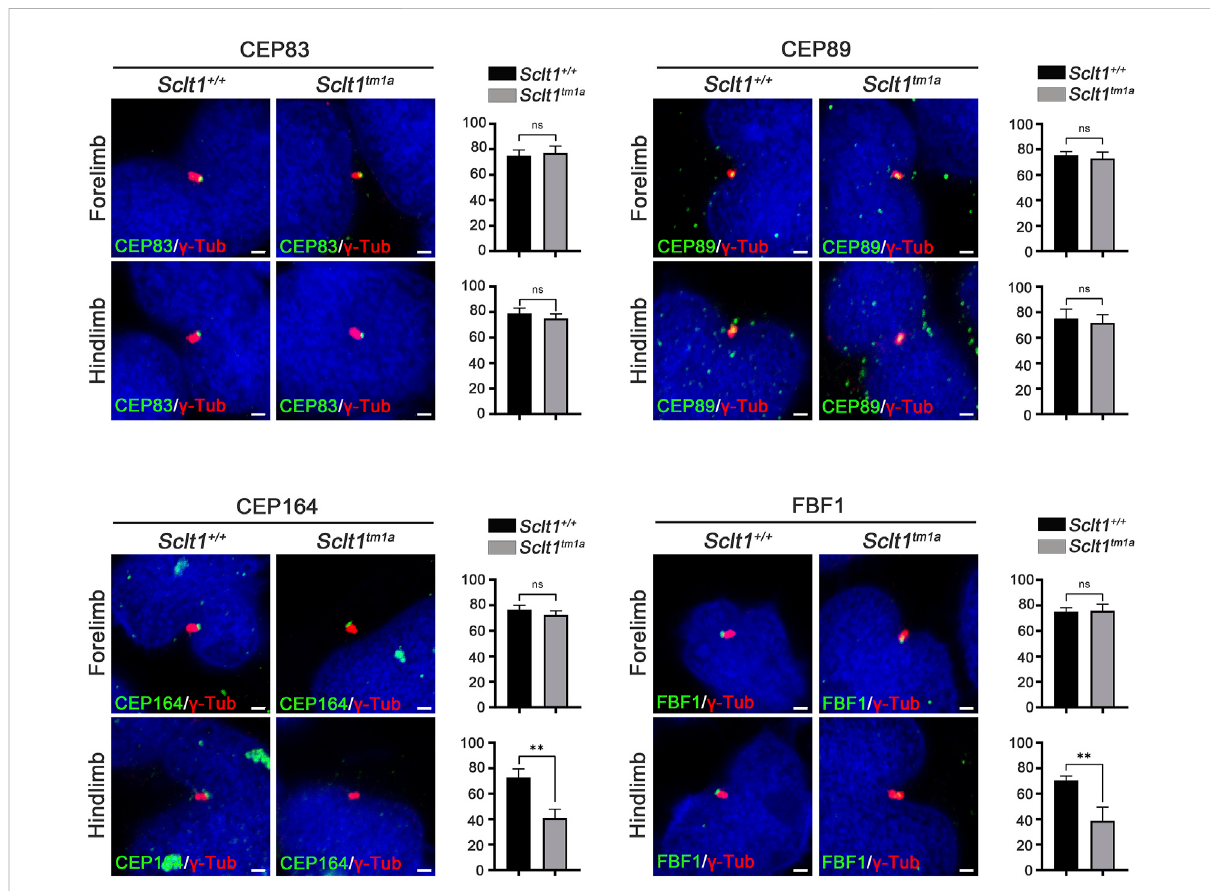
FIGURE 2 Sclt1 is involved in hierarchical DAP assembly during ciliogenesis of the hindlimb.To con fi rm SCLT1 mediated DAP assembly in mesenchymal cells obtained from E11.5 limb buds, we analyzed the localization of the DAP proteins such as CEP83, CEP89, CEP164, and FBF1 using immuno fl uorescent staining with indicated antibodies (green), and γ -Tub antibody (red) for basal body. Disruption of Sclt1 in mesenchymal cells prevents CEP164 and FBF1 recruitment to the basal body. Scale bars = 1